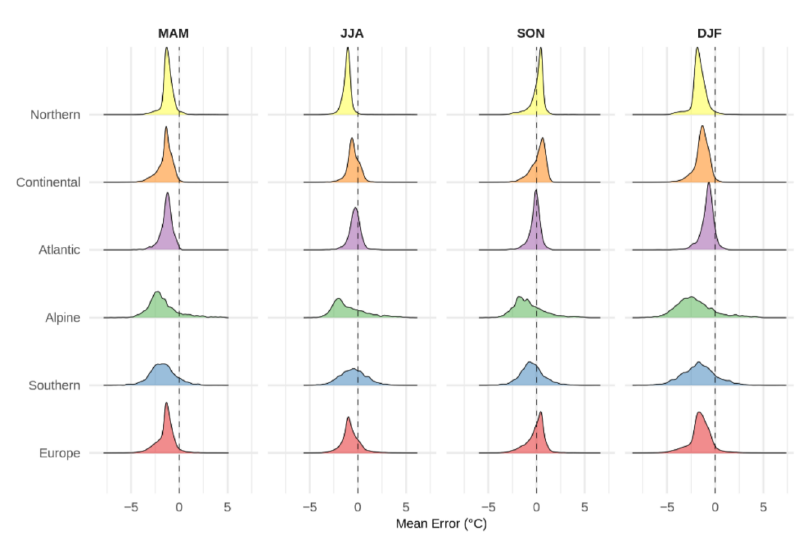
Figure 2. ME distributions of unadjusted ECMWF SEAS5 ensemble seasonal forecasts of 2-m mean air temperature (one-month lead time) for European sub-regions and whole domain. ME was computed with respect to ERA5 over